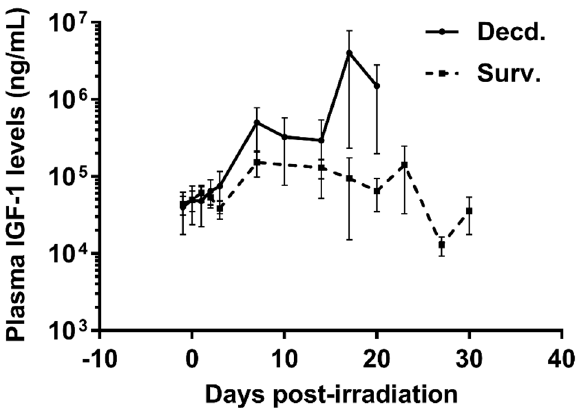
Figure 1. Plasma Insulin-like Growth Factor-1 (IGF-1) levels are increased in irradiated decedent Sinclair minipig (SMP). Plasma IGF-1 levels were assayed by ELISA assay at indicated days following irradiation until necropsy in survivor (Surv. n = 9) and decedent (Decd. n = 4) SMP. Note that in the days 17 and 20 post-irradiation there are measurements available from only two decedent animals.